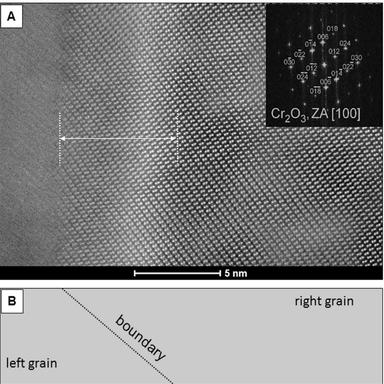
(A) - Atomic-resolution STEM-HAADF image of the fragment indicated with rectangle "8" in A; (B) - Symbolic representation of the position and inclination of chromia grains in the analyzed area relative to each other.